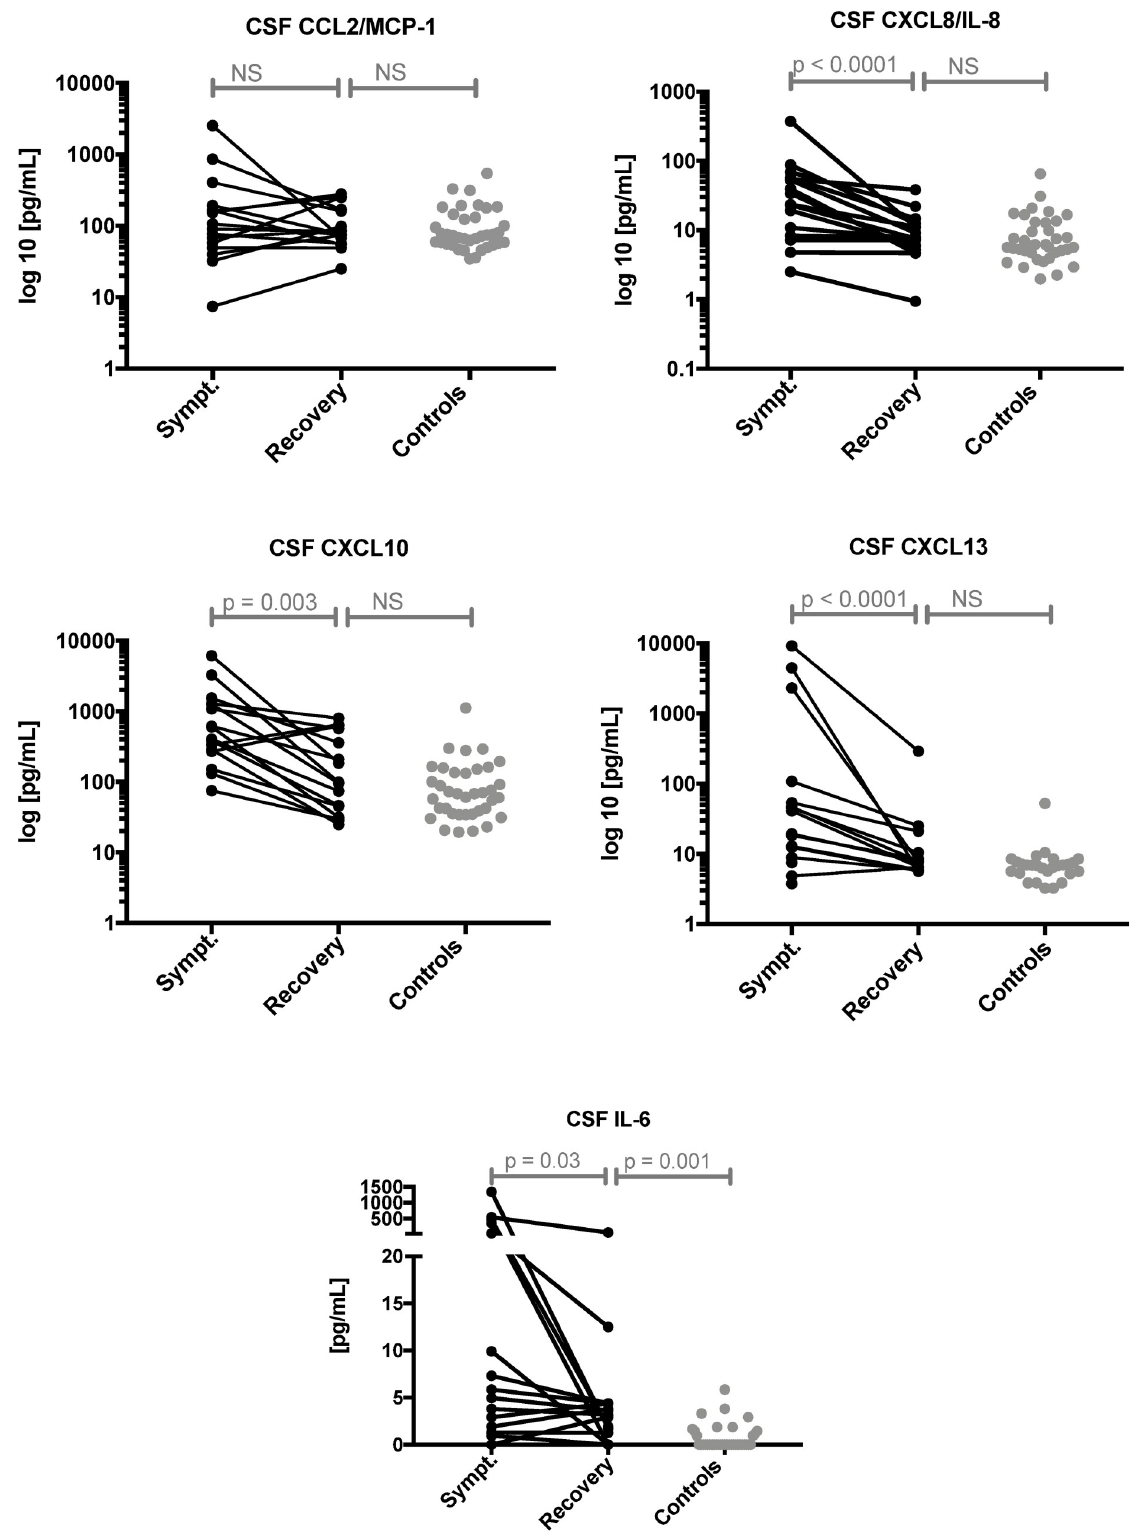
Fig 2. Comparison of CSF chemo/cytokine levels in symptomatic, recovery and control samples. Comparison of chemo/cytokine levels in paired symptomatic and recovery samples (n = 16) using the Wilcoxon signed-rank test and comparisons between recovery samples (n = 16) and controls (n = 37) using unpaired Mann-Whitney tests are displayed, the statistical significance is indicated. https://doi.org/10.1371/journal.pone.0219987.g002 PLOS ONE | https://doi.org/10.1371/journal.pone.0219987 July 29,